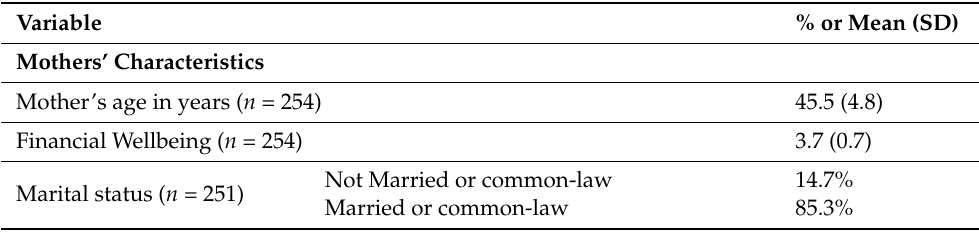
Table 1. Demographic characteristics of participants ( n =